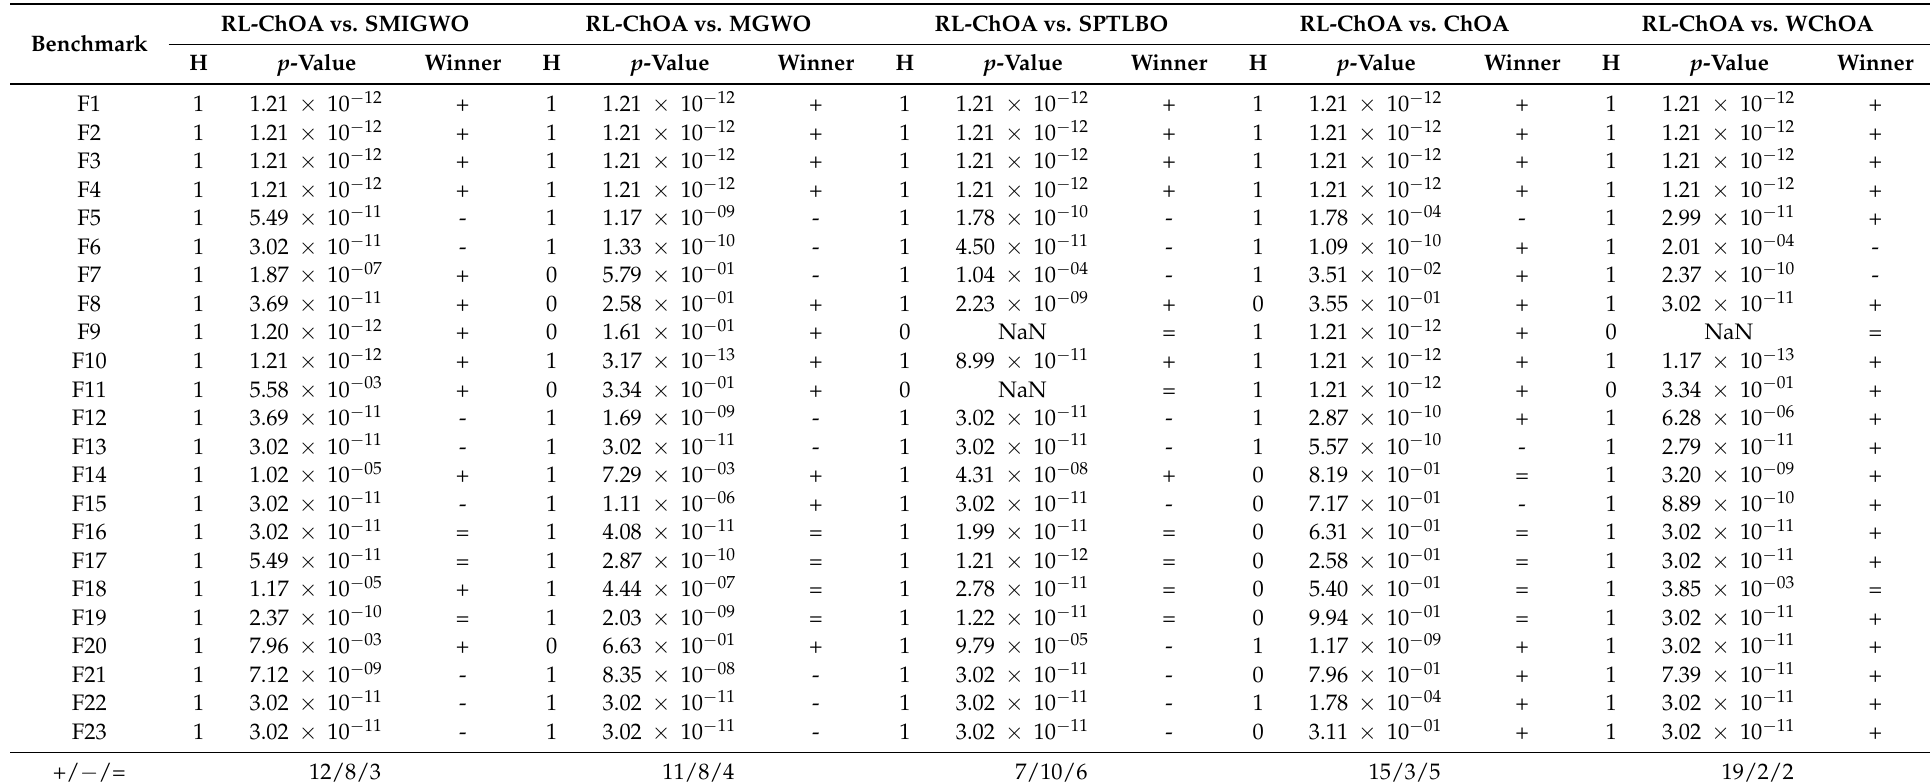
Table 8. Test statistical results of Wilcoxon’s rank-sum test. RL-ChOA vs. Benchmark